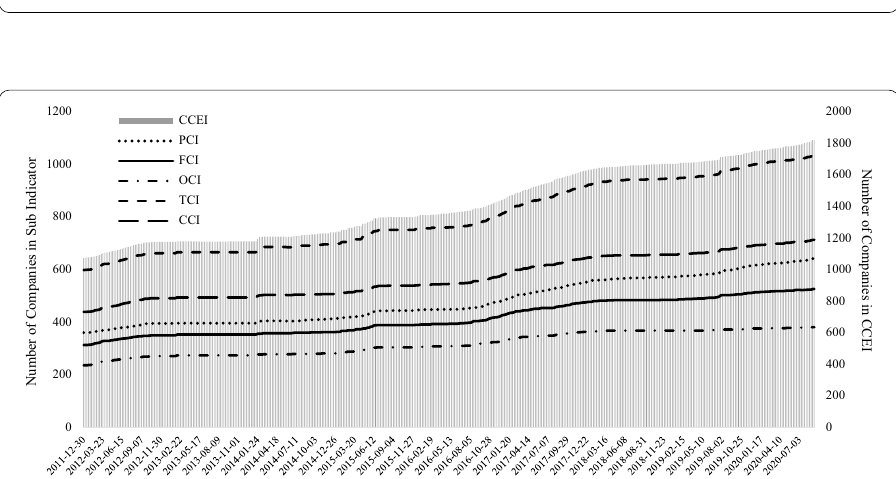
Fig. 2 The Proportion of CCEI and its Sub-Index Enterprises in the whole industry. Note The statistical results are based on RoyalFlush iFinD Index as of August 31,